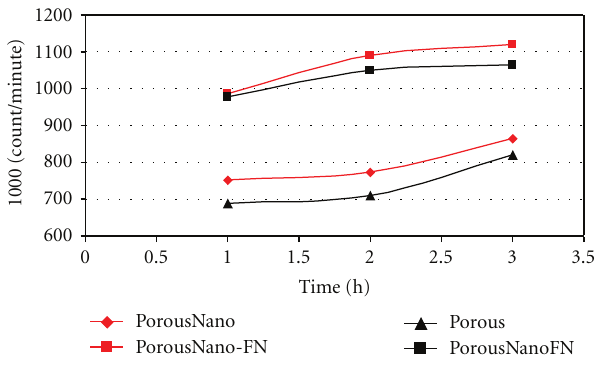
Figure 4: Radioactivity associated with osteoblasts on Porous, Porous-FN, PorousNano, and PorousNano-FN surfaces. The result- ing values were expressed as counts per minute